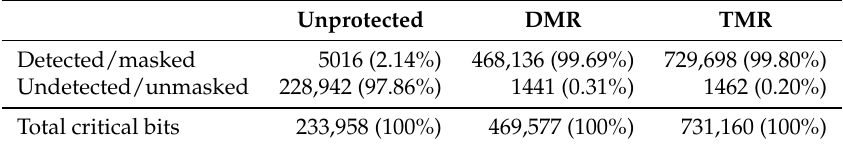
Table 7. Reliability results for the different unprotected and protected architectures (AVIRIS